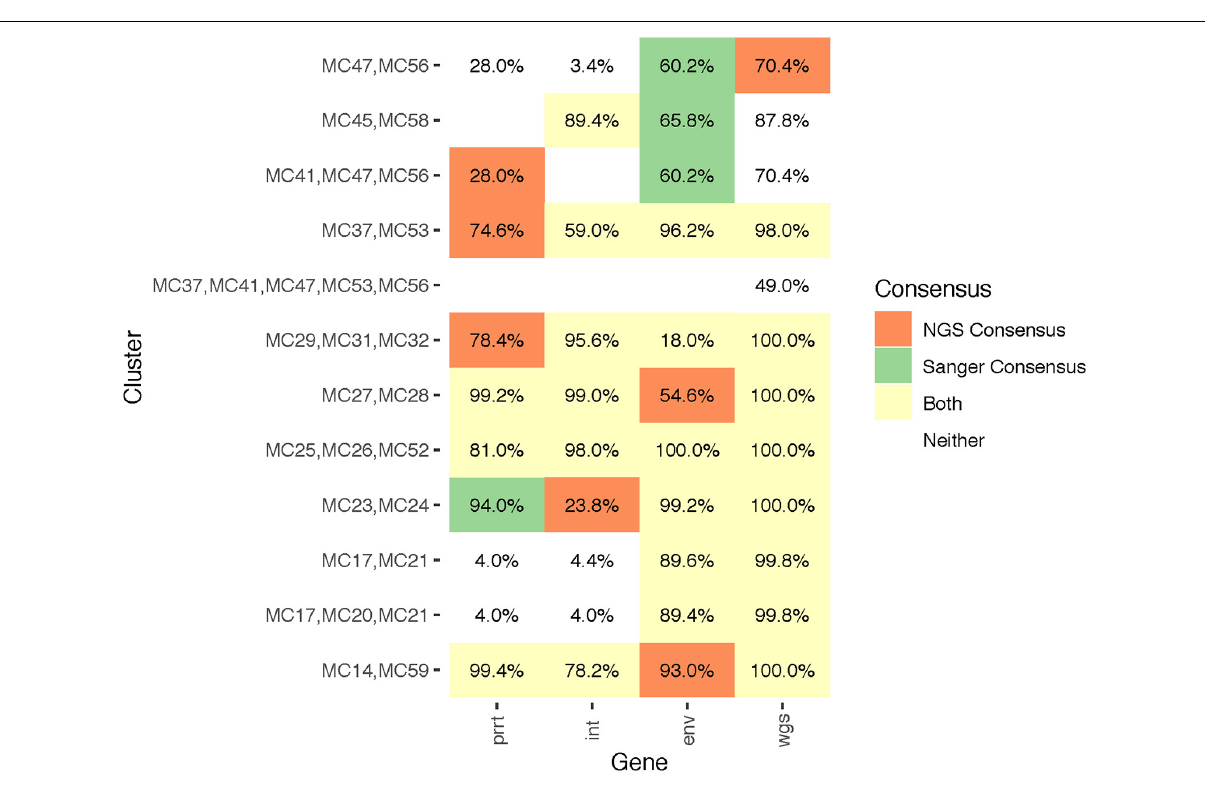
FIGURE 6 | Quantitative differences in profile-sampled cluster support across genomic regions. The figure illustrates the clusters and their subclusters ( Y axis) identified by Sanger versus NGS consensus sequences (colors; see legend) across genomic regions ( X axis). Numeric values indicate cluster support from the profile sampling method. A blank cell indicates that the cluster was not detected in that genomic